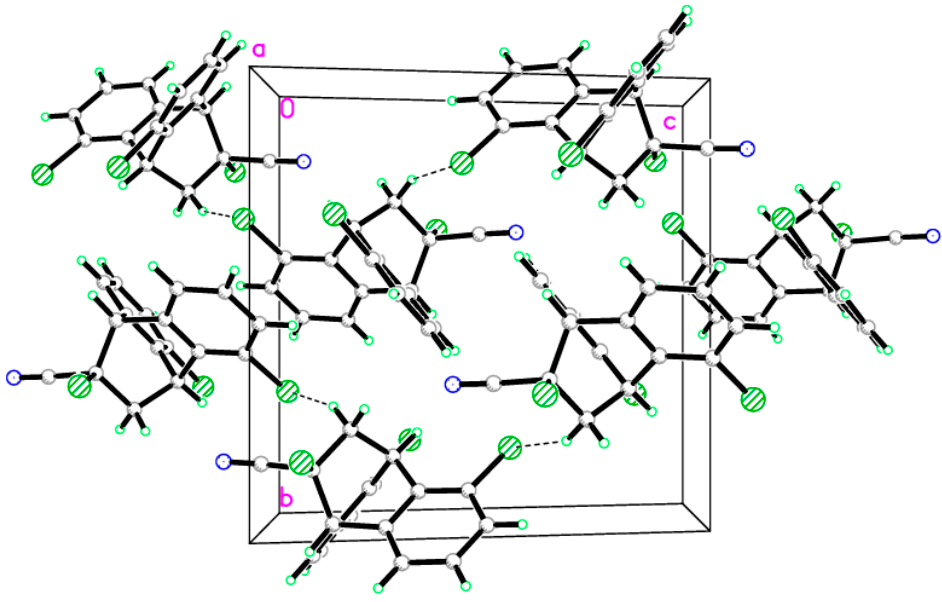
Figure 2. Molecular packing of isomer 1 with hydrogen bonds shown; the hydrogen bonds are drawn as dashed lines along the c axis.